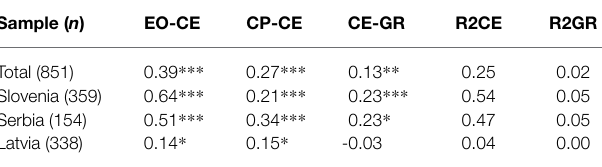
TABLE 6 | Structural equation modeling results (standardized coefficients and variance explained). Sample ( n